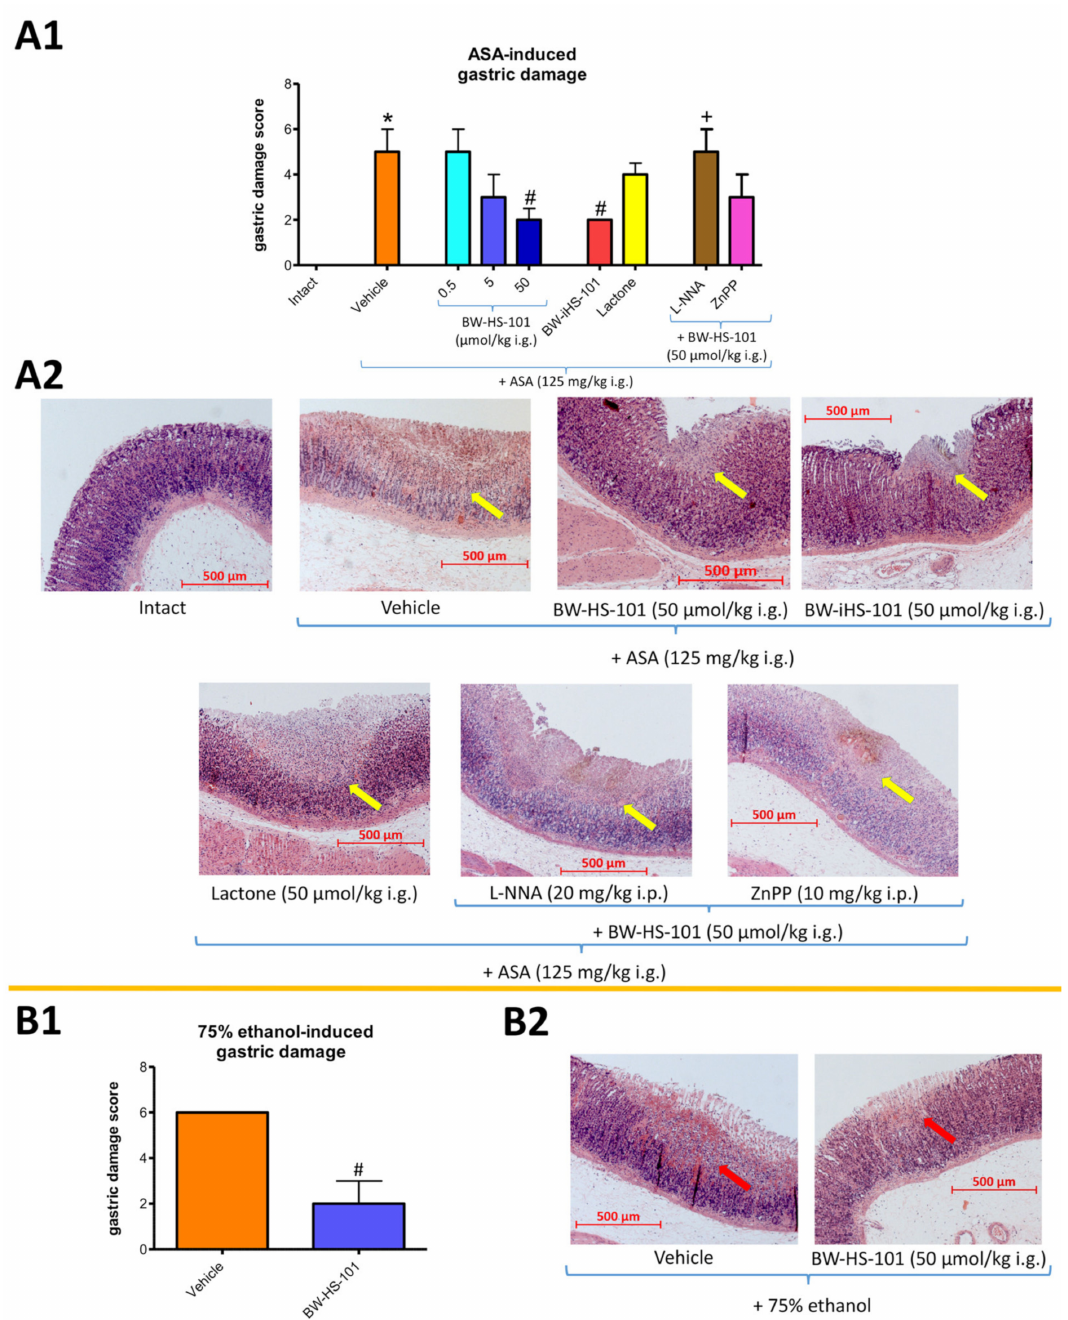
Figure 2. Gastric damage score ( A1 , B1 ) and representative histological slides ( A2 , B2 ) of gastric mucosa of rats administered i.g. with acetylsalicylic acid (ASA, 125 mg/kg) or 1 mL of 75% ethanol. Results are median ± interquartile range of five rats per each experimental group. Asterisk (*) indicates significant change as compared with intact ( p < 0.05). Hash (#) indicates significant change as compared with vehicle ( p < 0.05). Cross (+) indicates significant change as compared with BW-HS-101 (50 µ mol/kg) ( p < 0.05). ( A1 ): Gastric damage score in rats administered with ASA and pretreated i.g. 30 min earlier with vehicle, BW-HS-101 (0.5–50 µ mol/kg), BW-iHS-101 (50 µ mol/kg), lactone (50 µ mol/kg) or BW-HS-101 (50 µ mol/kg) combined with nitroarginine (L-NNA, 20 mg/kg i.p.) or zinc protoporphyrin IX (ZnPP, 10 mg/kg i.p.). ( A2 ): Representative histological slides of gastric mucosal damage induced by ASA (yellow arrows) in rats pretreated i.g. with vehicle, BW-HS-101 (50 µ mol/kg), BW-iHS-101 (50 µ mol/kg), lactone (50 µ mol/kg), or BW-HS-101 (50 µ mol/kg) combined with L-NNA or ZnPP. ( B1 ): Gastric damage score in rats administered with 75% ethanol and pretreated i.g. 30 min earlier with vehicle or BW-HS-101 (50 µ mol/kg). ( B2 ): Representative histological slides of gastric mucosal damage induced by 75% ethanol (red arrows) in rats pretreated i.g. with vehicle or BW-HS-101 (50 µ